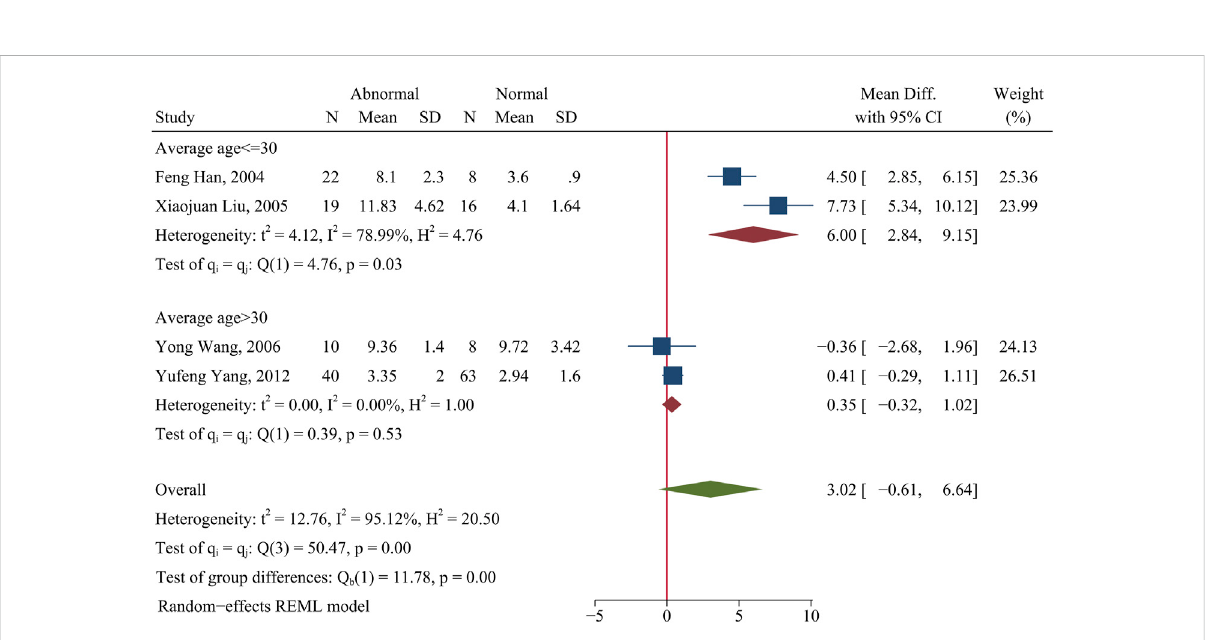
FIGURE 3 Forest plot of the percentage change of Th1 cells in SLE patients with abnormal kidney function compared with normal kidney function. The overall results (bottom) show the meta-analysis of 4 studies, and the other two results show meta-analyses of subgroups according to patient age. Abnormal: SLE patients with abnormal kidney function. Normal: SLE patients with normal kidney